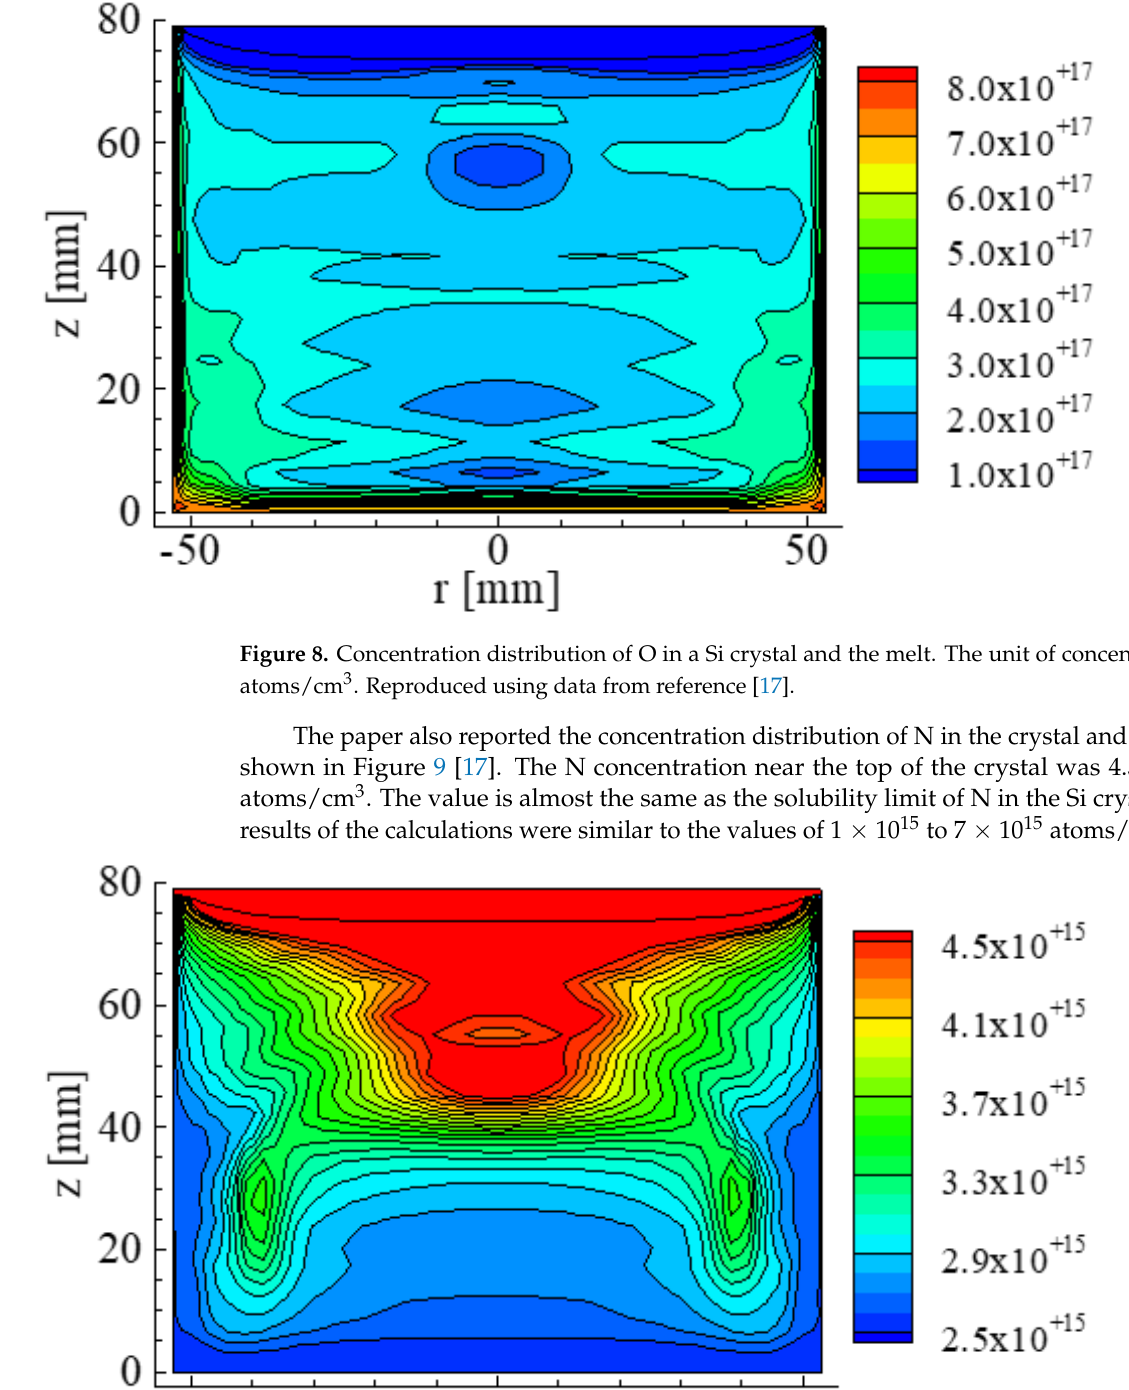
Figure 10. Concentration distribution of Si 3 N 4 in Si. The unit of concentration is atoms/cm 3 Repro- duced using data from reference [17]. Hisamatsu et al. [17] estimated that the area of this phenomena was located in region 1 of Figure 11. O evaporated from the top of the melt [18], the O concentration at the top of the melt decreased with an increase in crystal growth process. Conversely, N concen- tration in the melt increased as a function of crystal growth duration time due to the equi- librium segregation coefficient [12]. As a result, the O and N concentrations at the